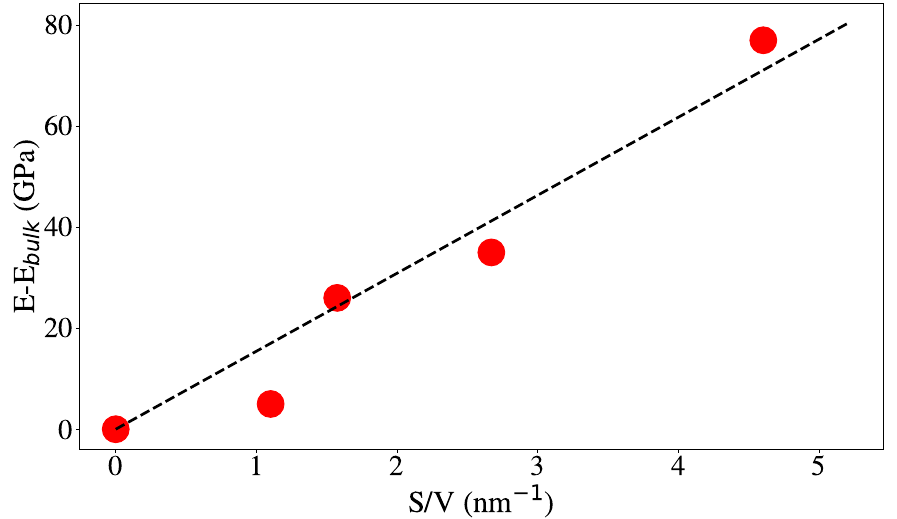
Figure 6. E vs. S/V for 20 sp 3 content. The results form the bulk, NW and NT of external radius of 2 nm, and internal radii of 0.5, 1.0 and 1.3 nm are shown from left to right.